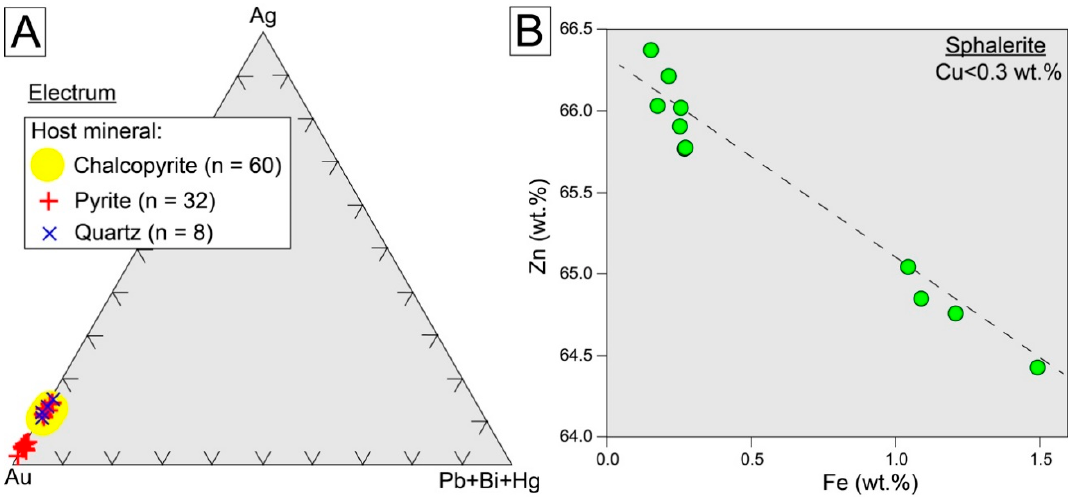
Figure 11. Chemical composition of electrum ( A ; Au–Ag–Pb + Bi + Hg ternary plot) and of sphalerite ( B ; Fe–Zn binary plot) analyzed from the Romero deposit. Concentrations are in wt % of the elements.